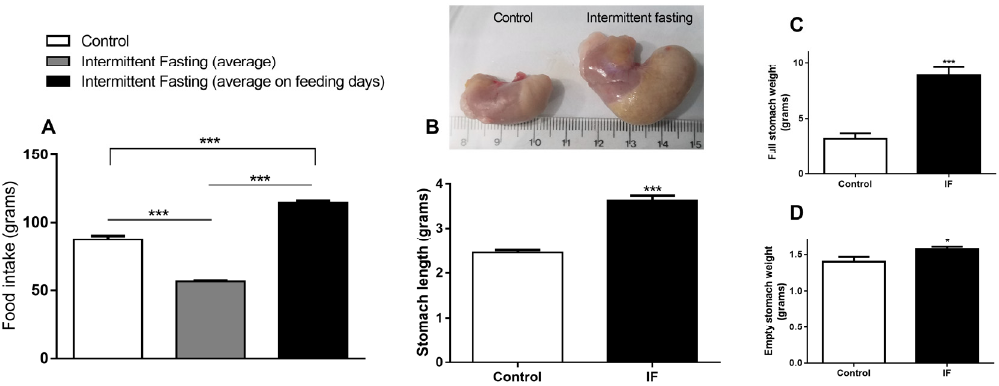
Figure 3. ( A ) Food intake, ( B ) stomach length, and ( C ) full and ( D ) empty stomach weight of Wistar rats submitted to IF for 12 weeks. The results are presented as the means ± standard error of the mean (SEM) with 10 different animals for each group. * p <0.05 and *** p <0.0005 compared to the control of the same period, as indicated by one-way ANOVA followed by Bartlett's test for equal variances (A) or Student's t-test.